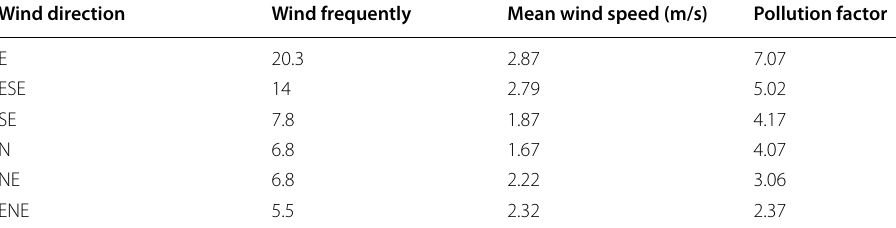
Table 1 Wind parameters of different wind direction at NKG Wind